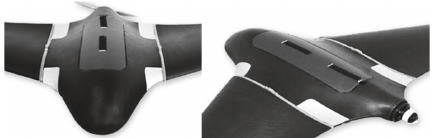
Figure 22: Antenna processing